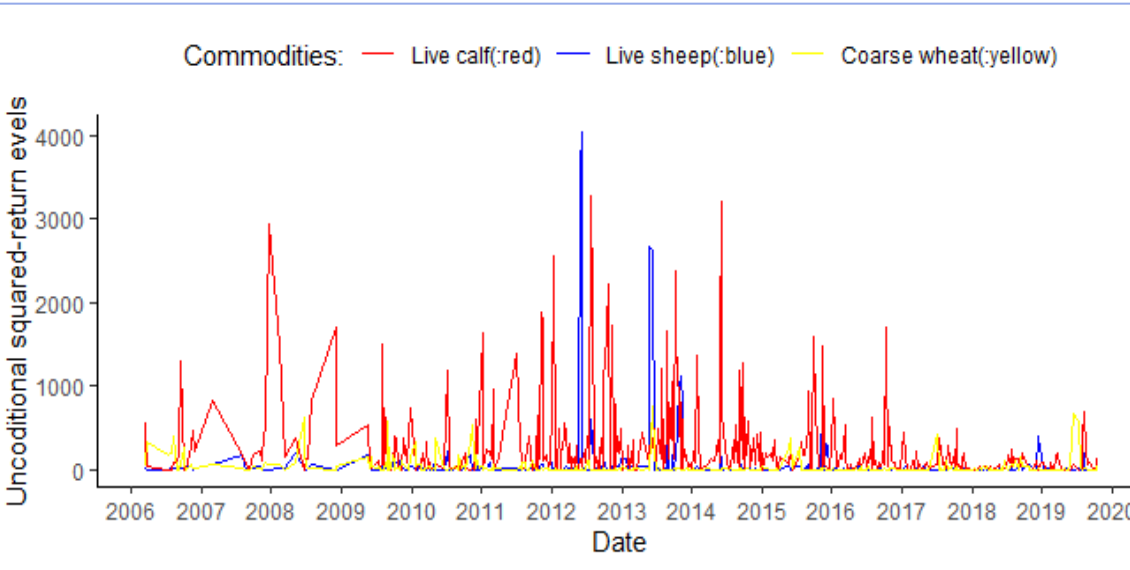
Figure 3. Squares of time-varying return series of live calves, live sheep, and coarse wheat.